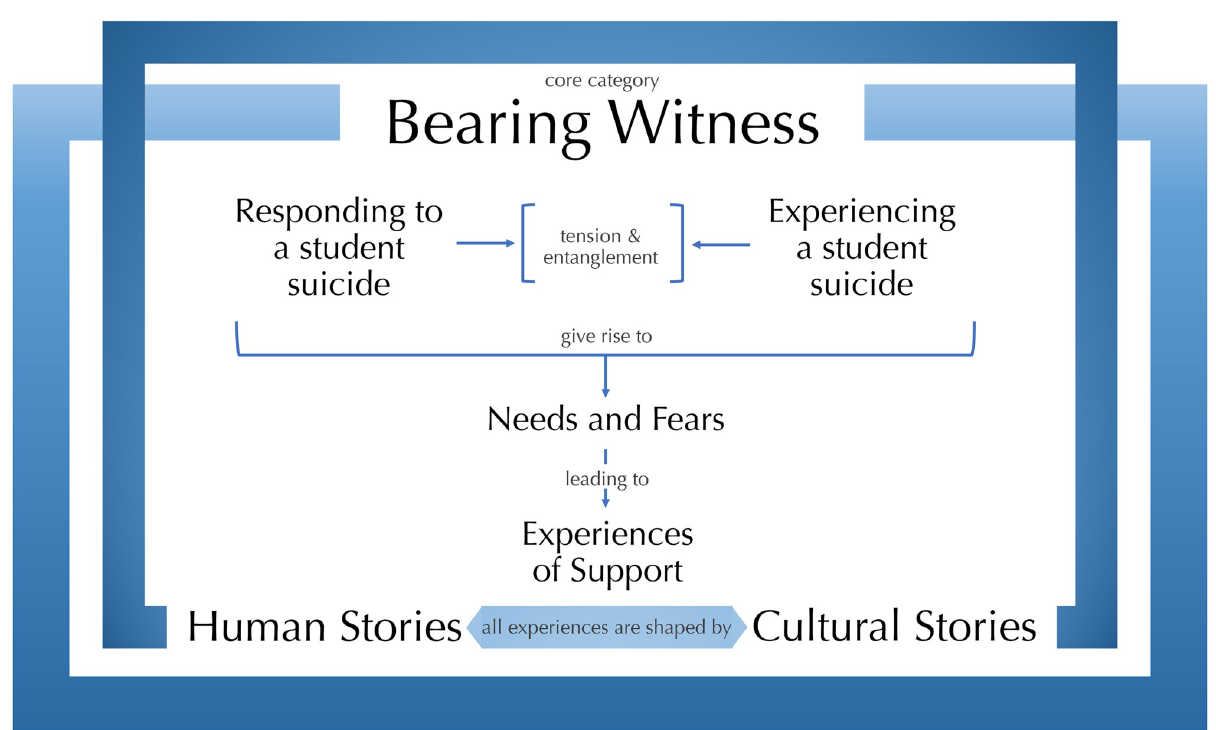
Fig 1. A grounded theory of the experiences of staff in UK HEIs who are exposed to a student death by suicide.